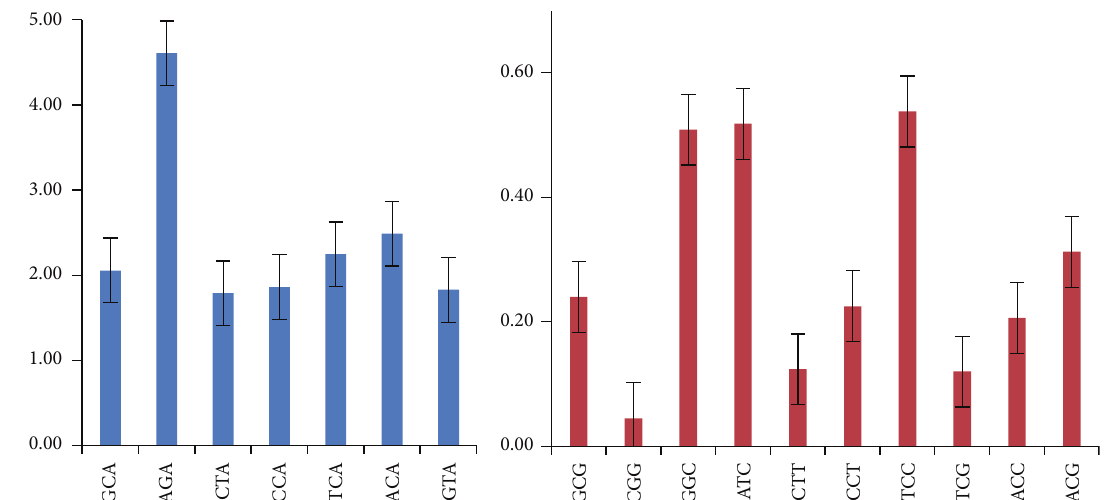
Figure 2: Over- and underrepresented codons in the genes used in the study. The overrepresented codons (RSCU > 1.6) are shown in blue, while the underrepresented (RSCU < 0.6) ones are shown in red.